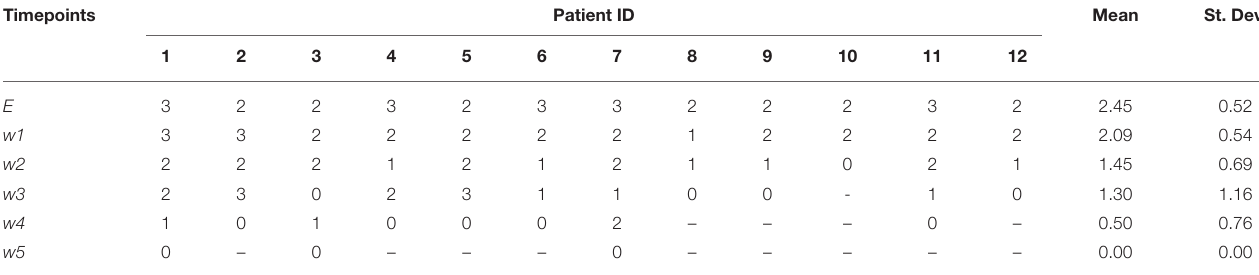
TABLE 3 | NES values for once-weekly FBM application.